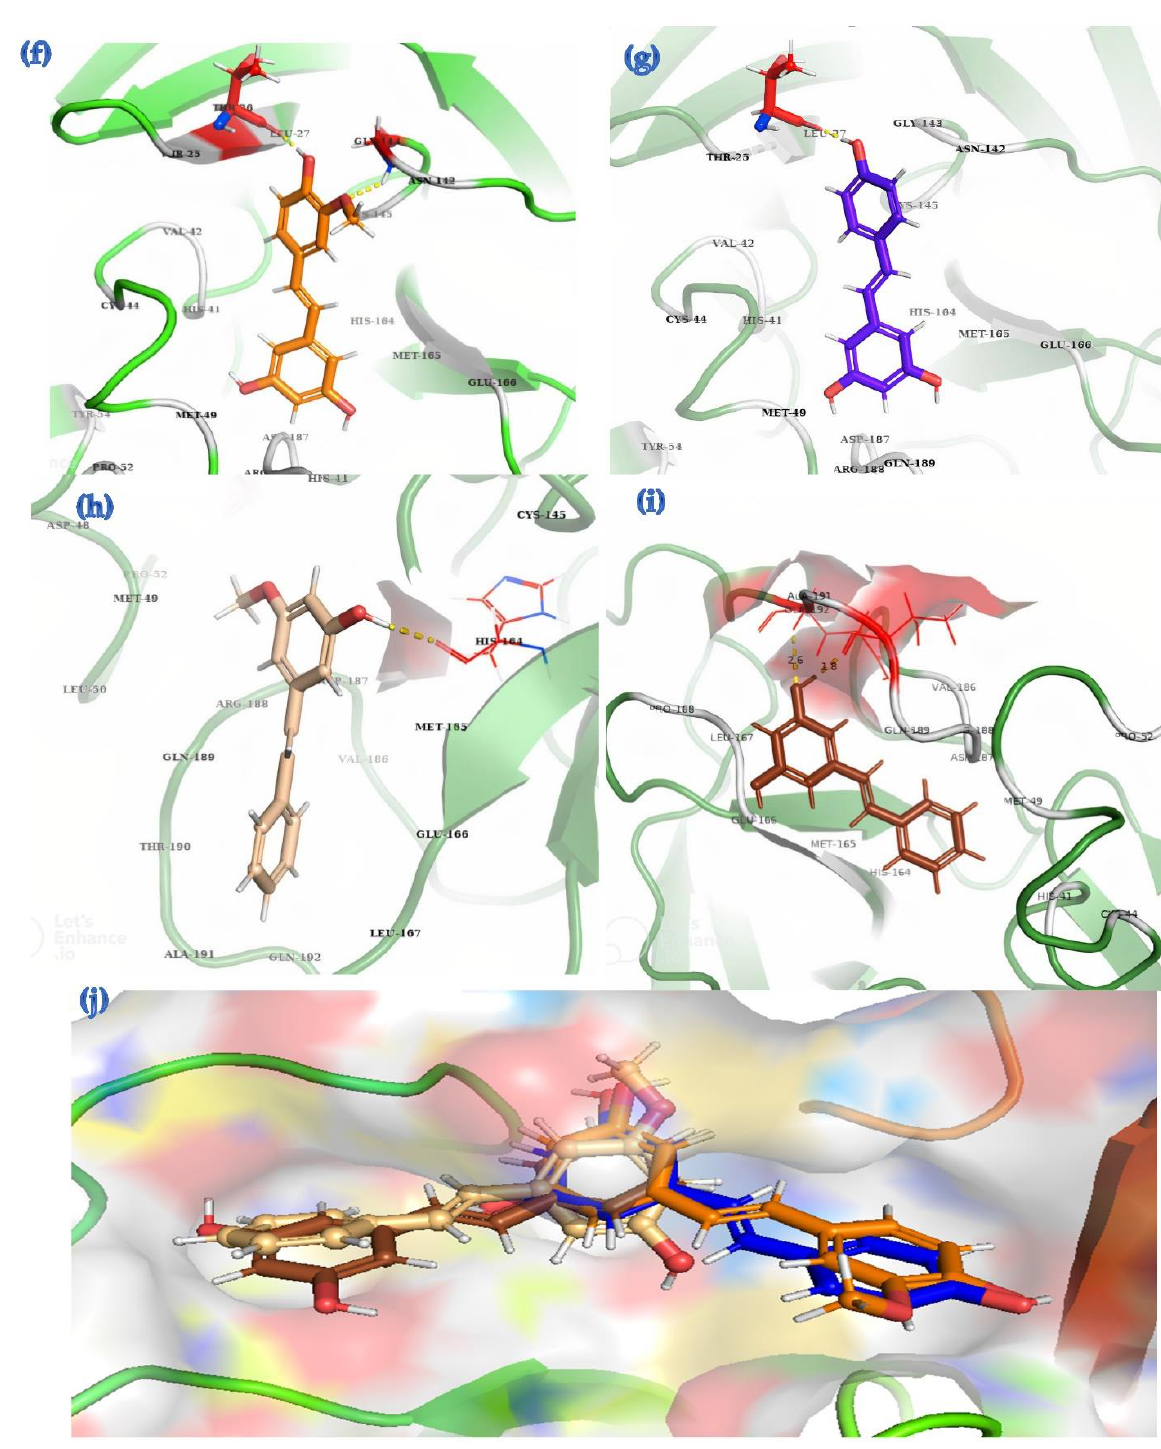
Figure 3. Predicted conformations for ligands within the binding pocket of Mpro. Mpro protein is depicted as a green color string-structure with GC376 (mauve color) ( a ); N3 structure (purple color) ( b ); astringin (Structure 1) (lime green color) ( c ); isorhapontin (Structure 2) (turquoise color) ( d ); piceatannol (Structure 3) (salmon color) ( e ). isorhapontigenin (Structure 4) (orange color) ( f ); resveratrol (Structure 5) (blue color) (g); PMME (Structure 6) (wheat color) ( h ); pinosylvin (Structure 7) (Brown color) ( i ); Structures 1–7 within the binding pocket of Mpro ( j ). Red color regions indicate polar residues and grey colors indicate non-polar residues of the M pro protein.